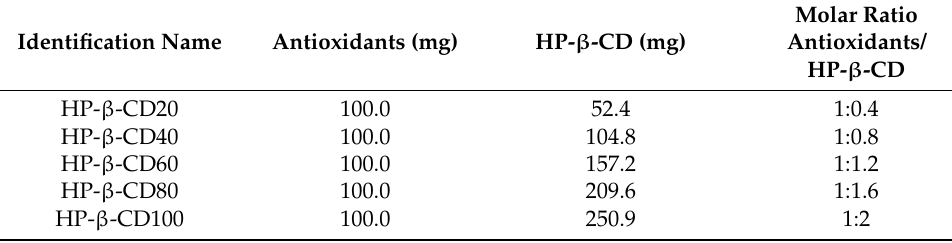
Table 2. Composition of the antioxidant/HP- β -CD